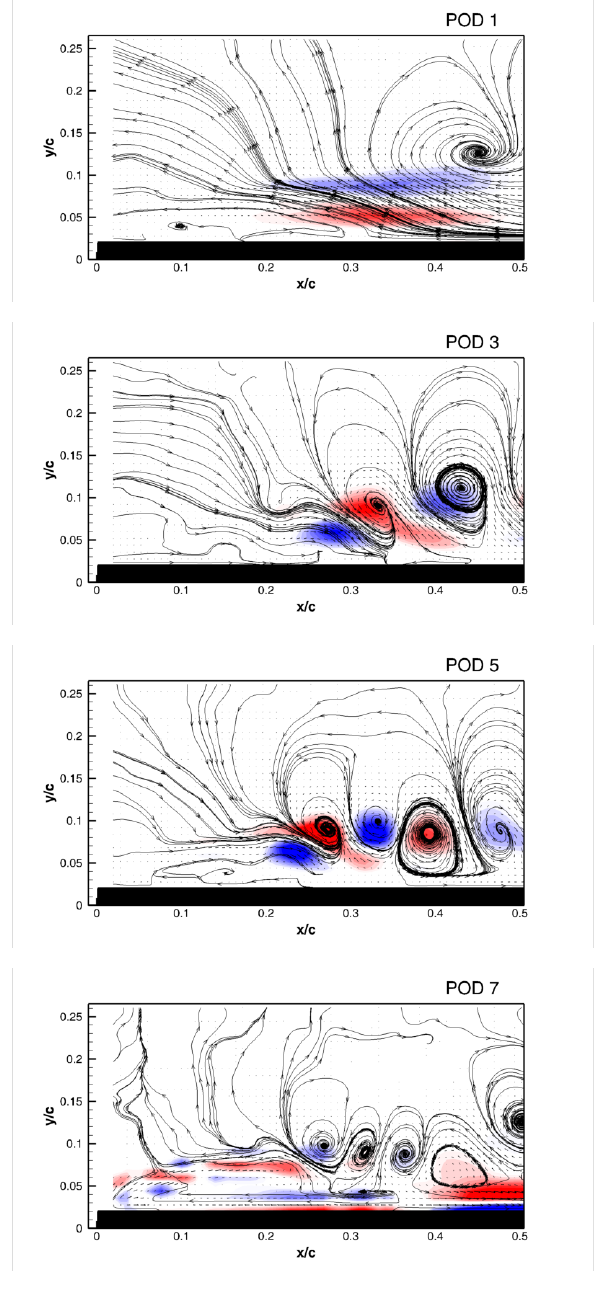
Fig. 5. Some examples of POD evaluated for first half of the suction side